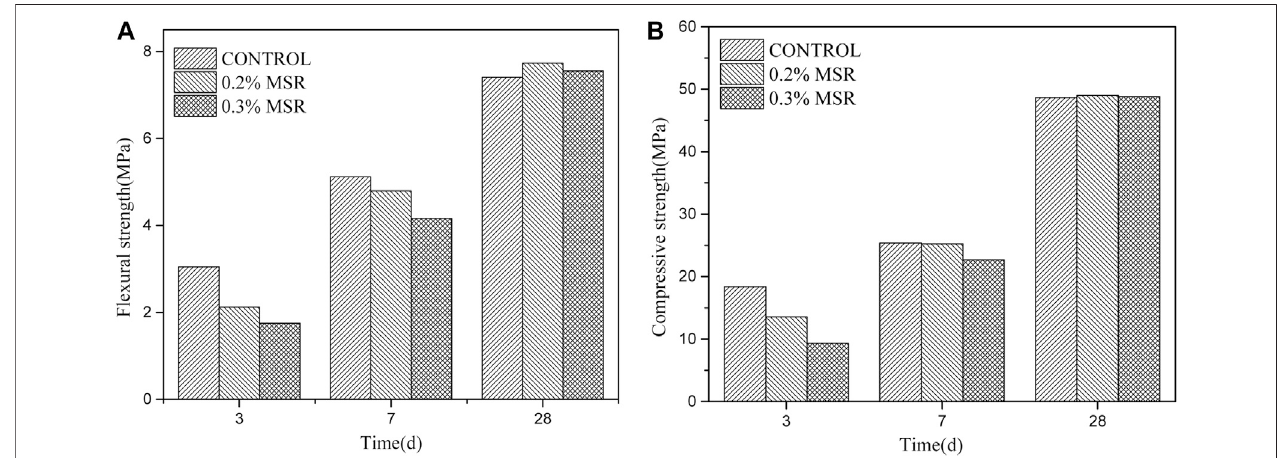
Frontiers in Materials |